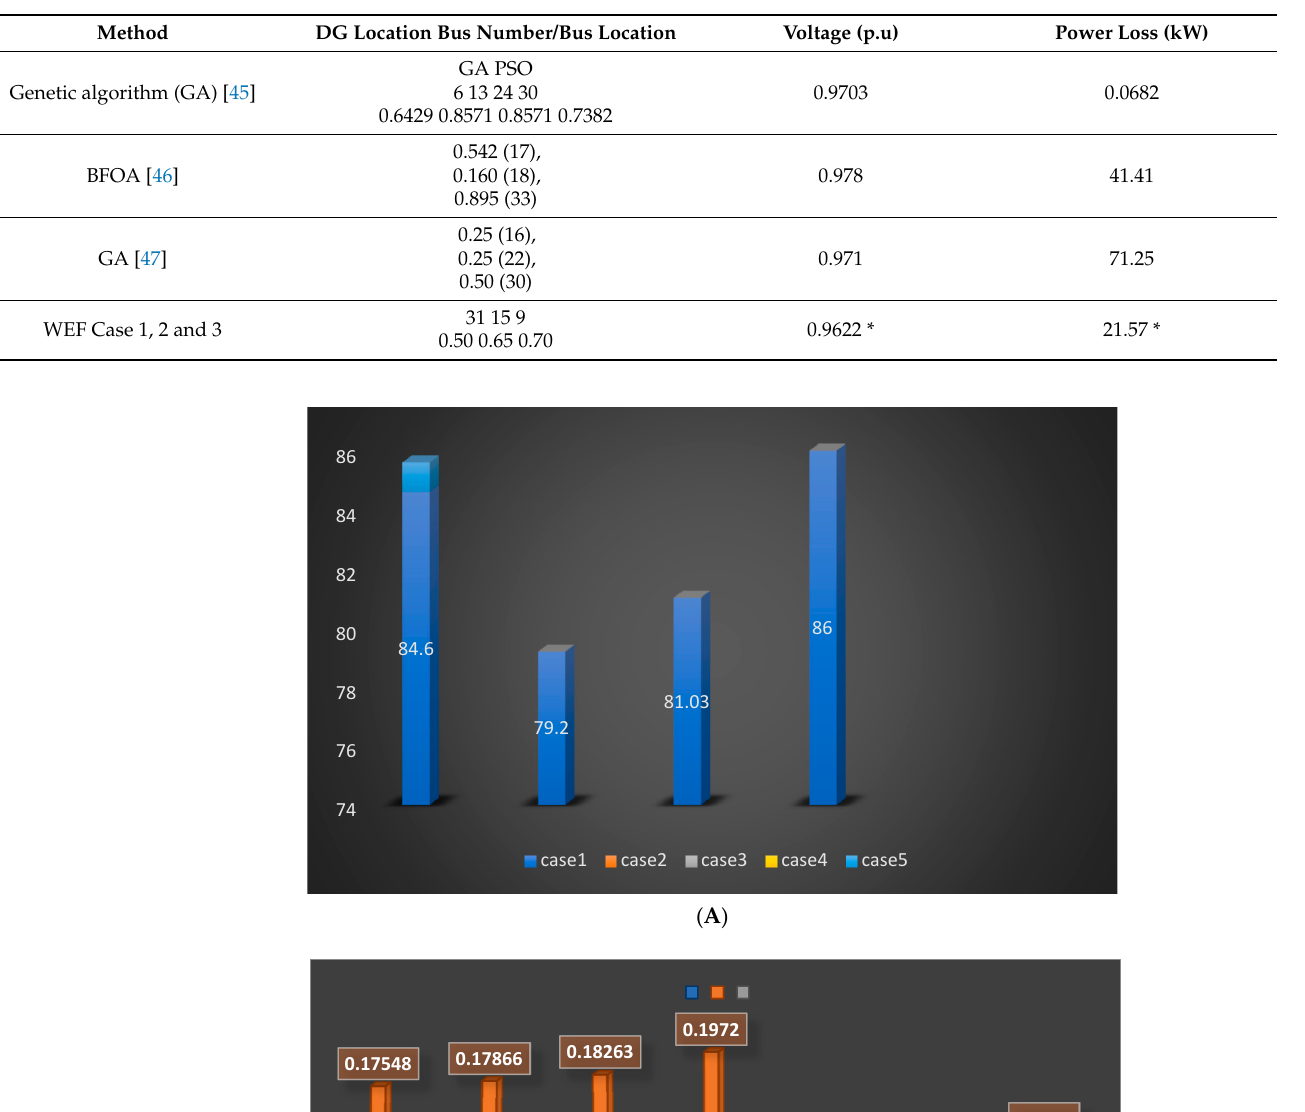
Table 5. Compares the results of the various methods for the test systems for the allocation of a single and multiple DG units.